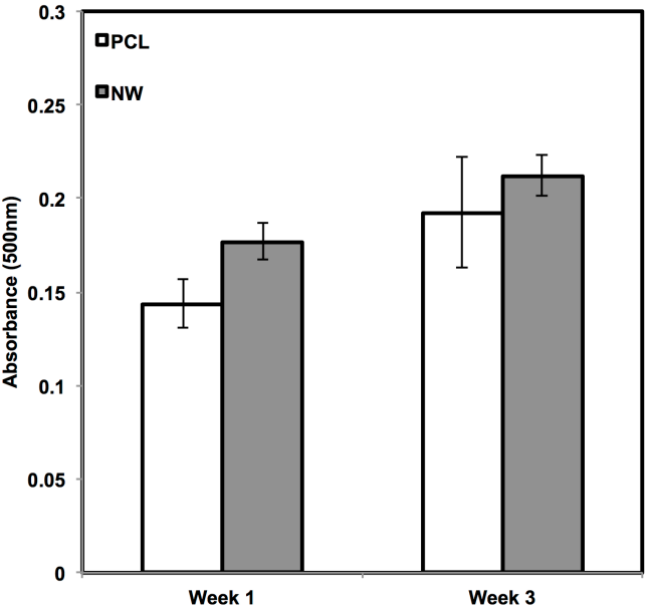
Figure 13. Oil red O (lipid) staining of PCL and NW after 1, 2 and 3 weeks of culture in adipogenic conditions as well as quantification of oil red O absorbance after 1 and 3 weeks of culture.